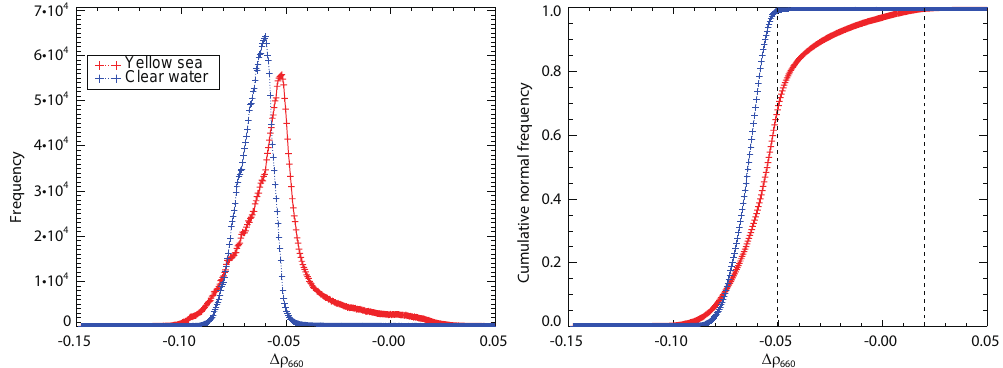
Figure 3. Frequency and cumulative normal frequency of (cid:49)ρ 660 over the Yellow Sea and over clear water.